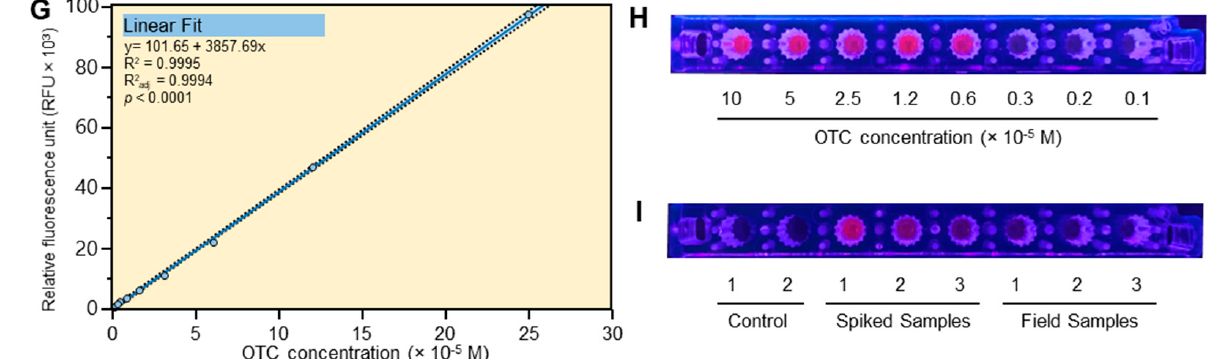
Figure 1. Optimization of the europium method using citrate as a sensitizing agent. Effect of pH presented as 2-D column ( A ) & polynomial fit ( B ), citrate presented as 2-D column ( C ) & polynomial fit ( D ), europium presented as 2-D column ( E ) & polynomial fit ( F ), and OTC ( G ) concentration on the fluorescence intensity of Eu-OTC-Cit complex. Data are the means ± SD of three replicates ( n = 3). Columns with different letters are significantly different by Tukey HSD ( p < 0.05). Fluorescence imaging of OTC in standard ( H ), spiked samples ( I ), and field samples ( I ). Spiked and field samples were extracted using 1 M HCl containing 2.2% trichloroacetic acid and cleaned using an HLB cartridge before being mixed with europium and citrate in tris buffer (pH 8.5). Samples were placed in a 96-well microplate and their image was taken under ultraviolet light (400 nm).